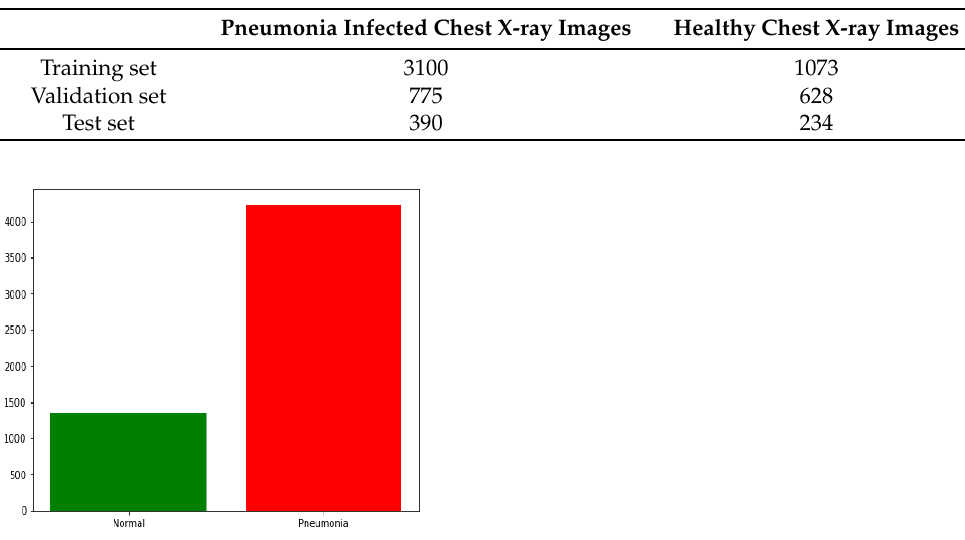
Table 2. Dataset description.